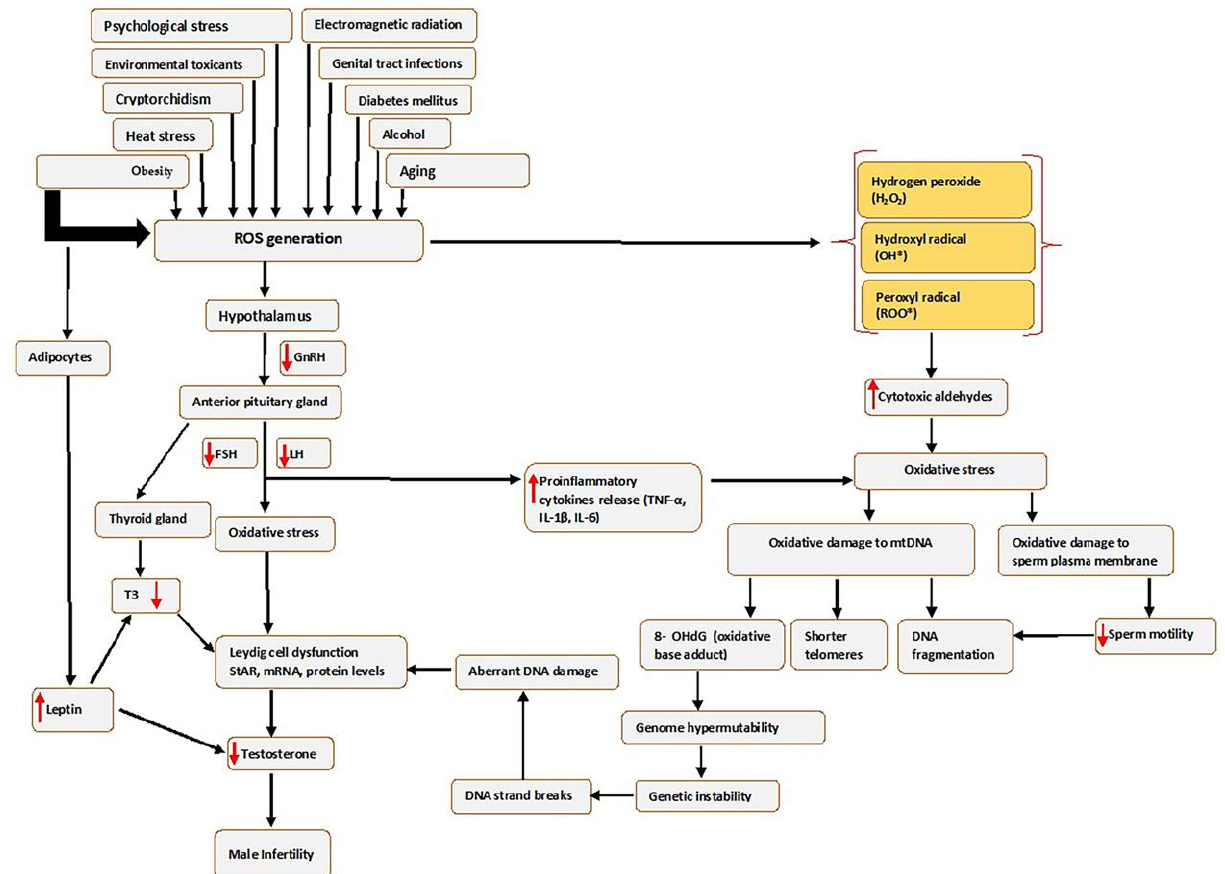
Figure 1. Causes of seminal oxidative stress and oxidative DNA damage. Various factors can lead to or affect the generation of reactive oxygen species (ROS) in the male germ line, which creates oxidative stress. Abbreviations: FSH-Follicle stimulating hormone; IL-6-interleukin 6; LH-luteinizing hormone; mRNA-messenger RNA; ROS, Reactive oxygen species; StAR-steroidogenic acute regulatory protein; TNF- α -Tumour necrosis factor alpha; T3, Triiodothyronine; 8 OHdG-8-hydroxy- 2′ - deoxyguanosine. Red arrows pointing up indicates increase; red arrows pointing downwards indicates a decrease.